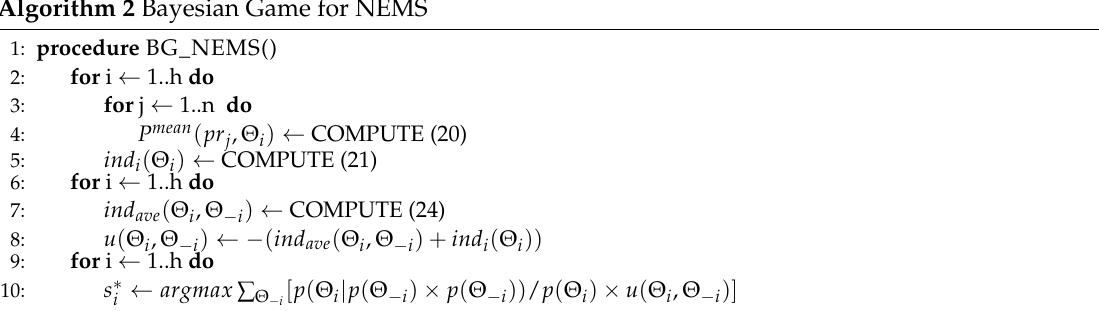
Algorithm 2 Bayesian Game for